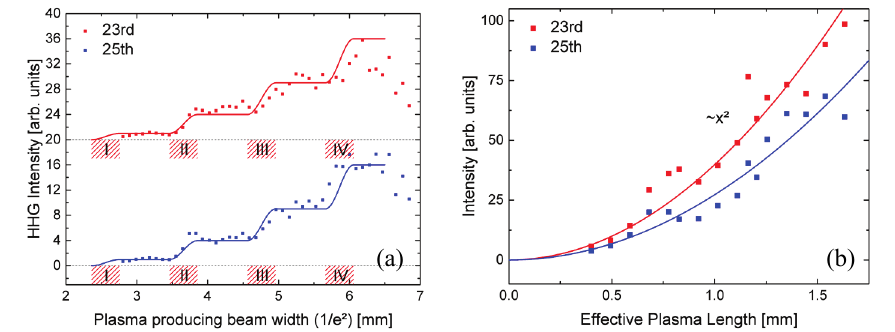
Fig. 2. Dependence of the intensity on the width of the plasma producing beam (a) and the effective plasma length showing the quadratic dependence of a phase-matched source (b). The target dimensions are 0.4 mm target disks and 0.7 mm spacing. The intensity is normalized to the maximal intensity of the 23rd harmonic generated in an unstructured